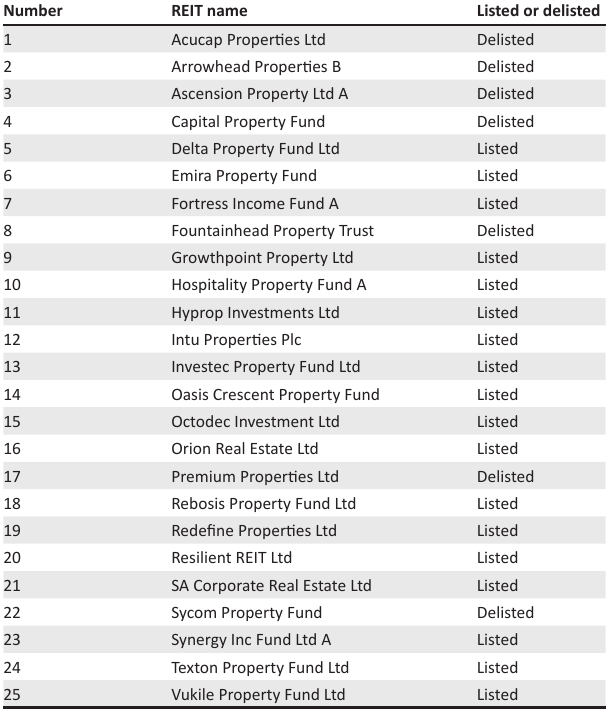
TABLE 1-A1: Sample of real estate investment trusts used for